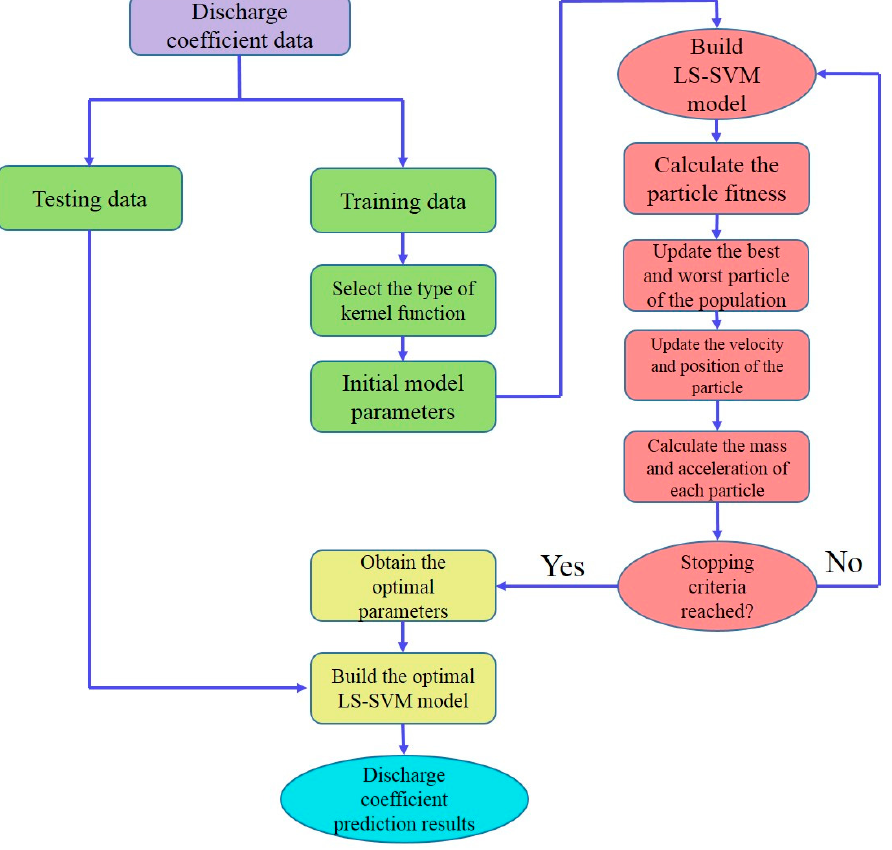
Figure 4. Diagram of LSSVM–GSA model for estimating the discharge coe ffi cient.